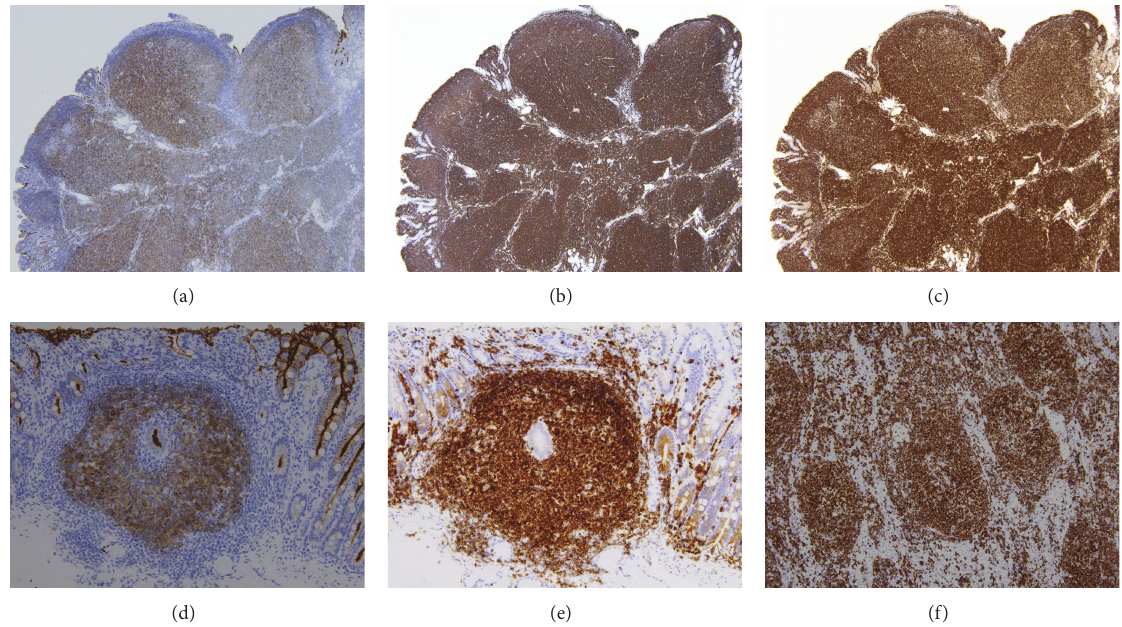
Figure 6: Immunohistochemical findings of follicular lymphoma. ((a)–(f)) Atypical lymphoid cells are positive for CD10 (a) and CD20 (b). BCL2 protein is intensively expressed in the centers of the follicles (c). Atypical lymphocytes in small nodular lesions (Figure 5(c)) around the mass of the ampulla of Vater are immunohistochemically positive for CD10 (d) and BCL2 (e). In regional lymph nodes (Figure 5(d)) in the duodenum, BCL2 protein is intensively expressed in the centers of the follicles